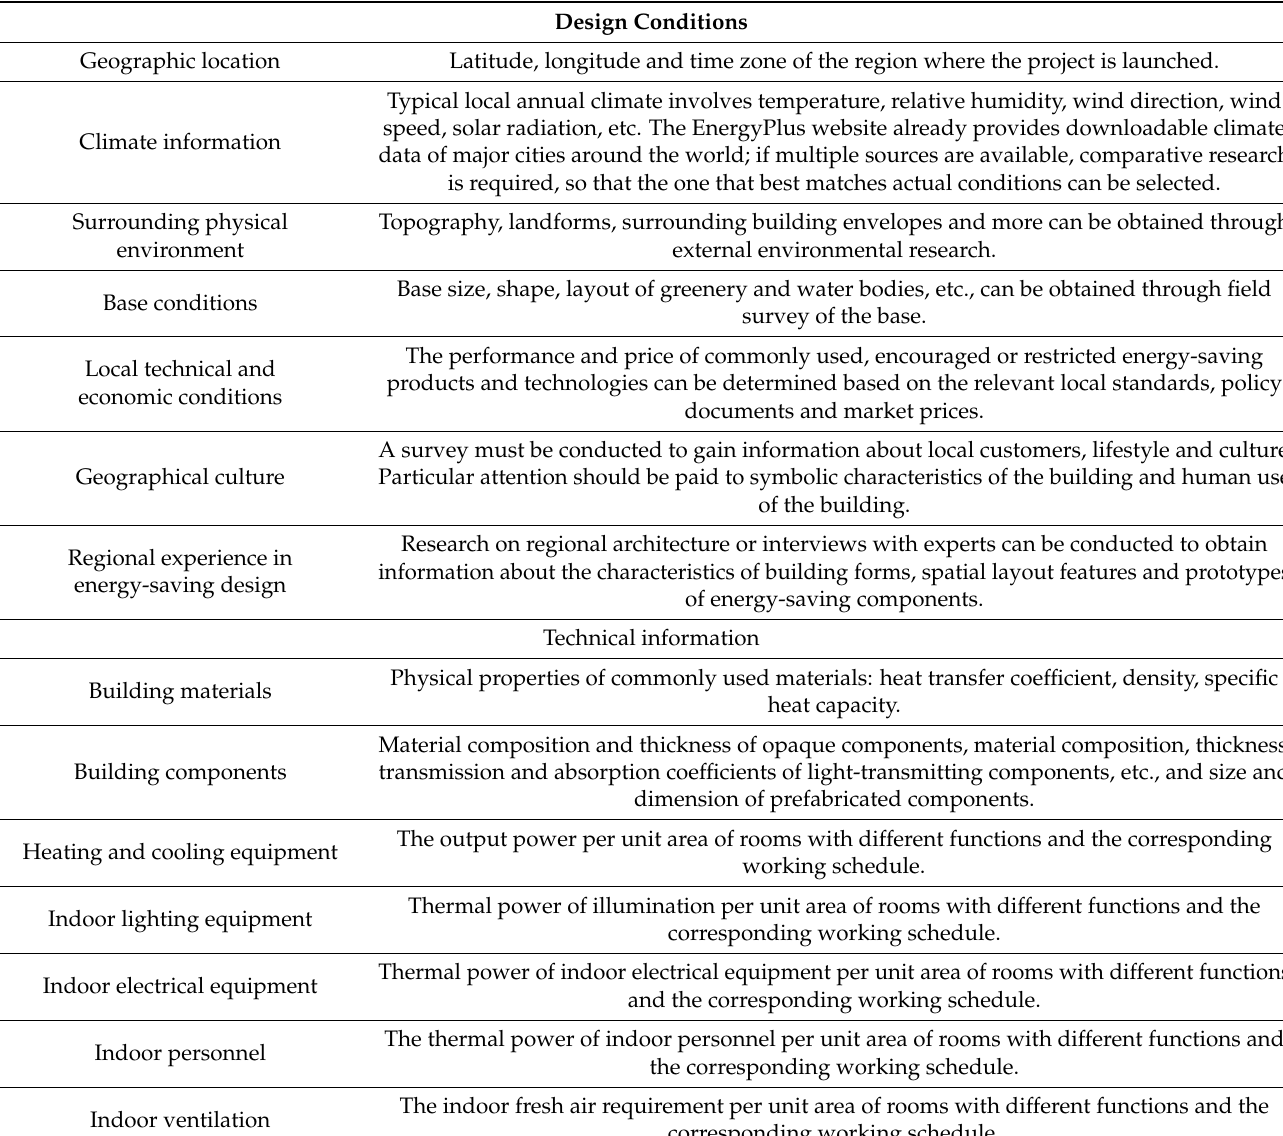
Table 5. Classification of parameters required for integrated